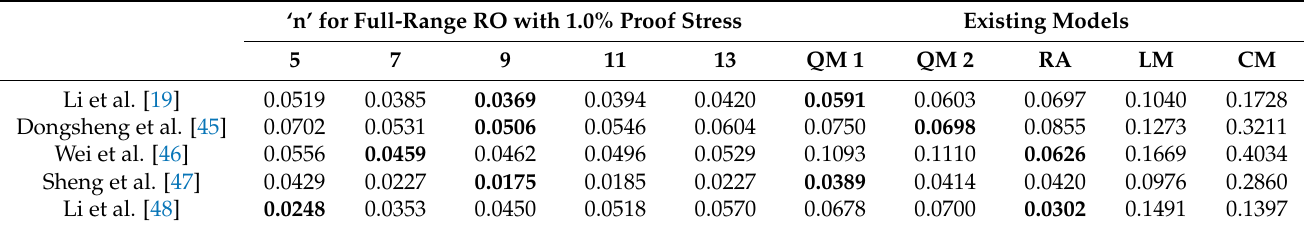
Table 6. Weighted least squares of the full-range RO model with n = 5, 7, 9, 11, 13. ‘n’ for Full -Range RO with 1.0% Proof